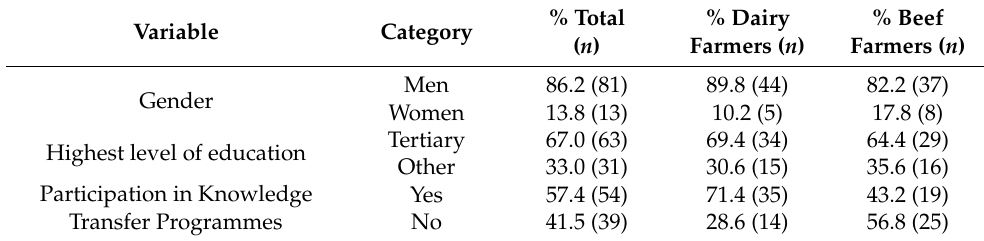
Table 1. Demographics of Dairy and Beef Farmer Respondents